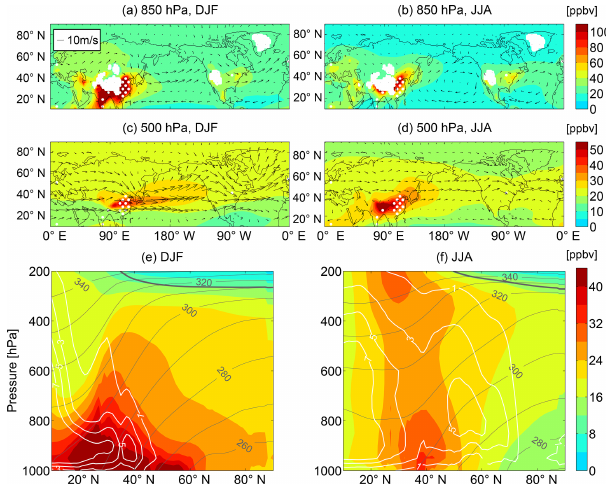
Figure 1. Ensemble mean of the horizontal distribution of CO50 concentration (shades, units: ppbv) at levels of (a, b) 850hPa and (c, d) 500hPa, and ensemble mean of the zonal-mean CO50 concen- tration cross sections (e, f) during (a, c, e) DJF and (b, d, f) JJA. In (a) – (d) , horizontal winds ( u , v ) are overlaid as vectors, and regions of CO50 sources are highlighted by white stipples within which CO50 emission fluxes are larger than 0 . 4 × 10 − 9 kgm − 2 s − 1 . In (e) and (f) , isentropic surfaces are overlaid as dark gray isopleths (units: K), the tropopause is marked as the bold dark gray curve, and re- gional convective mass flux (CMF) over East Asia (110–140 ◦ E) is denoted by white contours (units: 10 − 3 kgm − 2 s − 1 ).